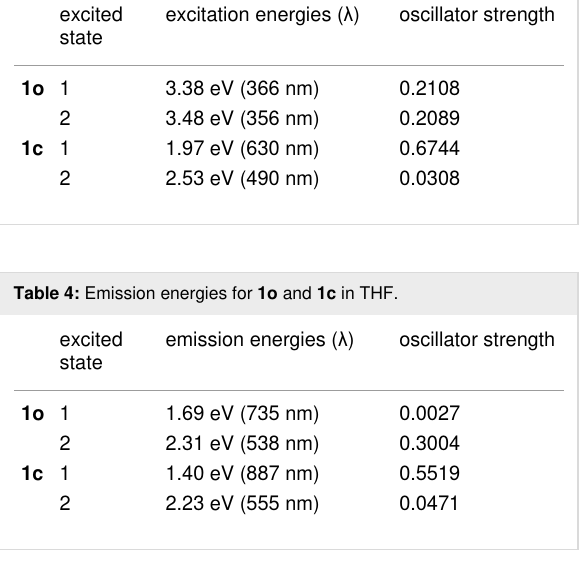
Table 3: Excitation energies for 1o and 1c in THF.